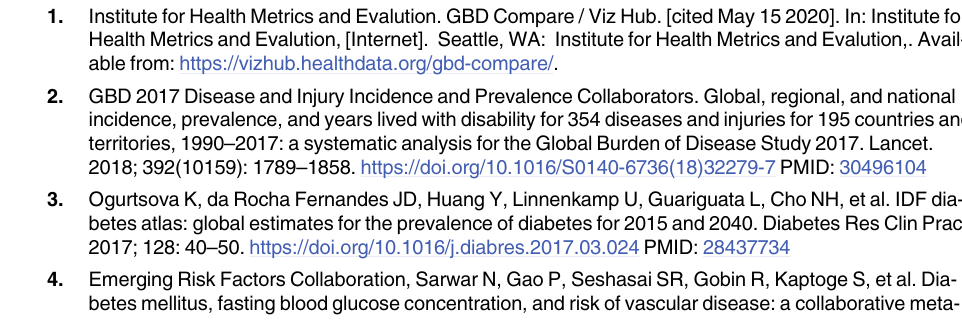
S1 Fig. Estimated DALYs by gender and age group. DALYs, disability-adjusted life years. (TIF) S2 Fig. Estimated YLLs by gender and age group. YLLs, years of life lost. (TIF) S3 Fig. Estimated YLDs depending on complications. YLDs, years lived with disability. (TIF) S1 Table. Ingredient code of anti-diabetic drugs. S2 Table. ICD-10 codes of diabetic complications. ICD, International Classification of Dis-